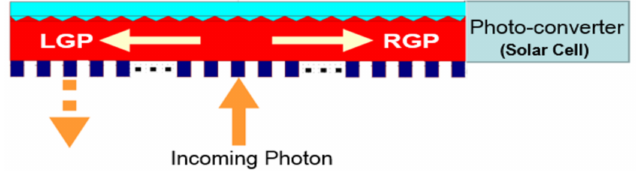
Figure 5. 3D photons going into a spatially symmetric 2D-waveguide equipped with a photoelectric converter at its right